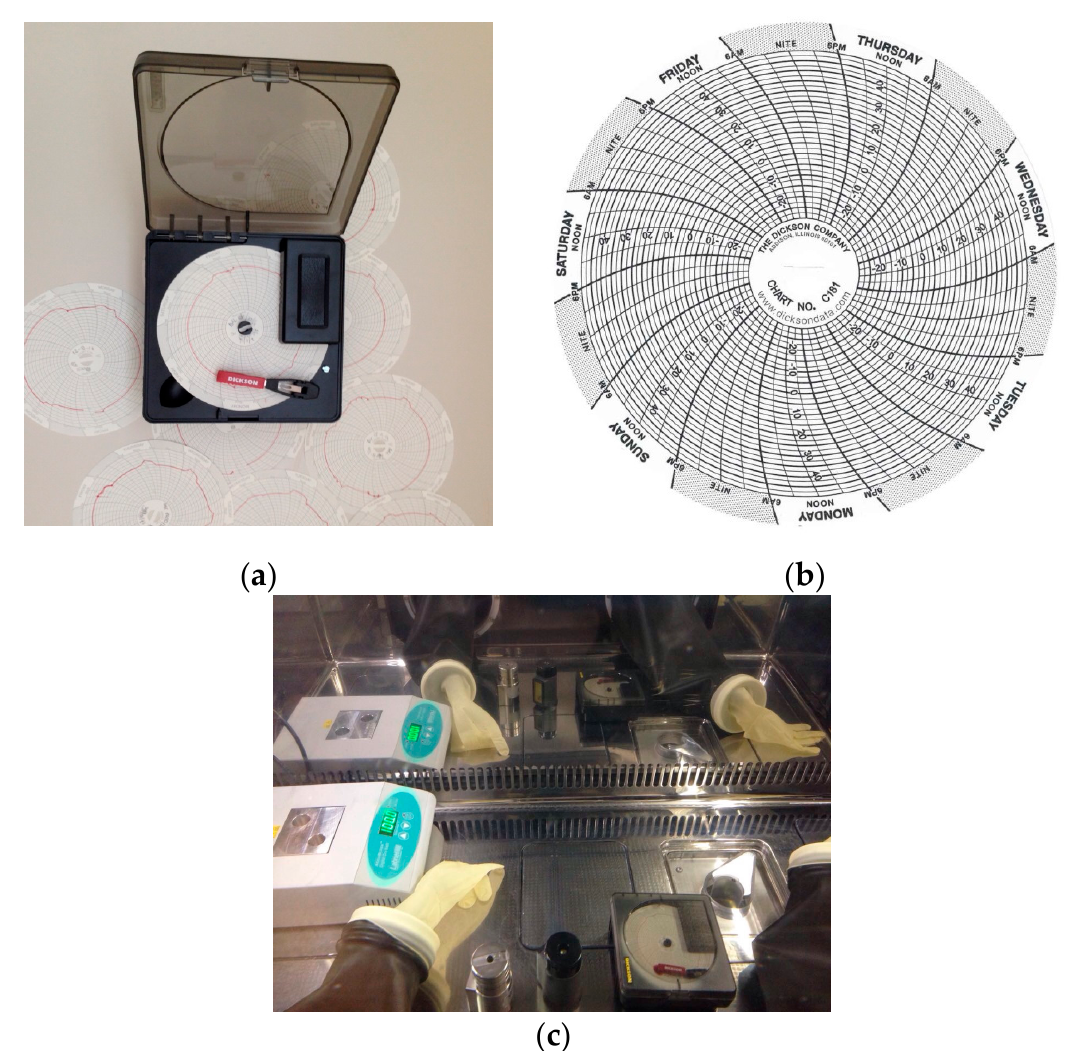
Figure 2. Graphic recorder ( a , b ) diagram disks (Dickson); and ( c ) recorder position in the work area.